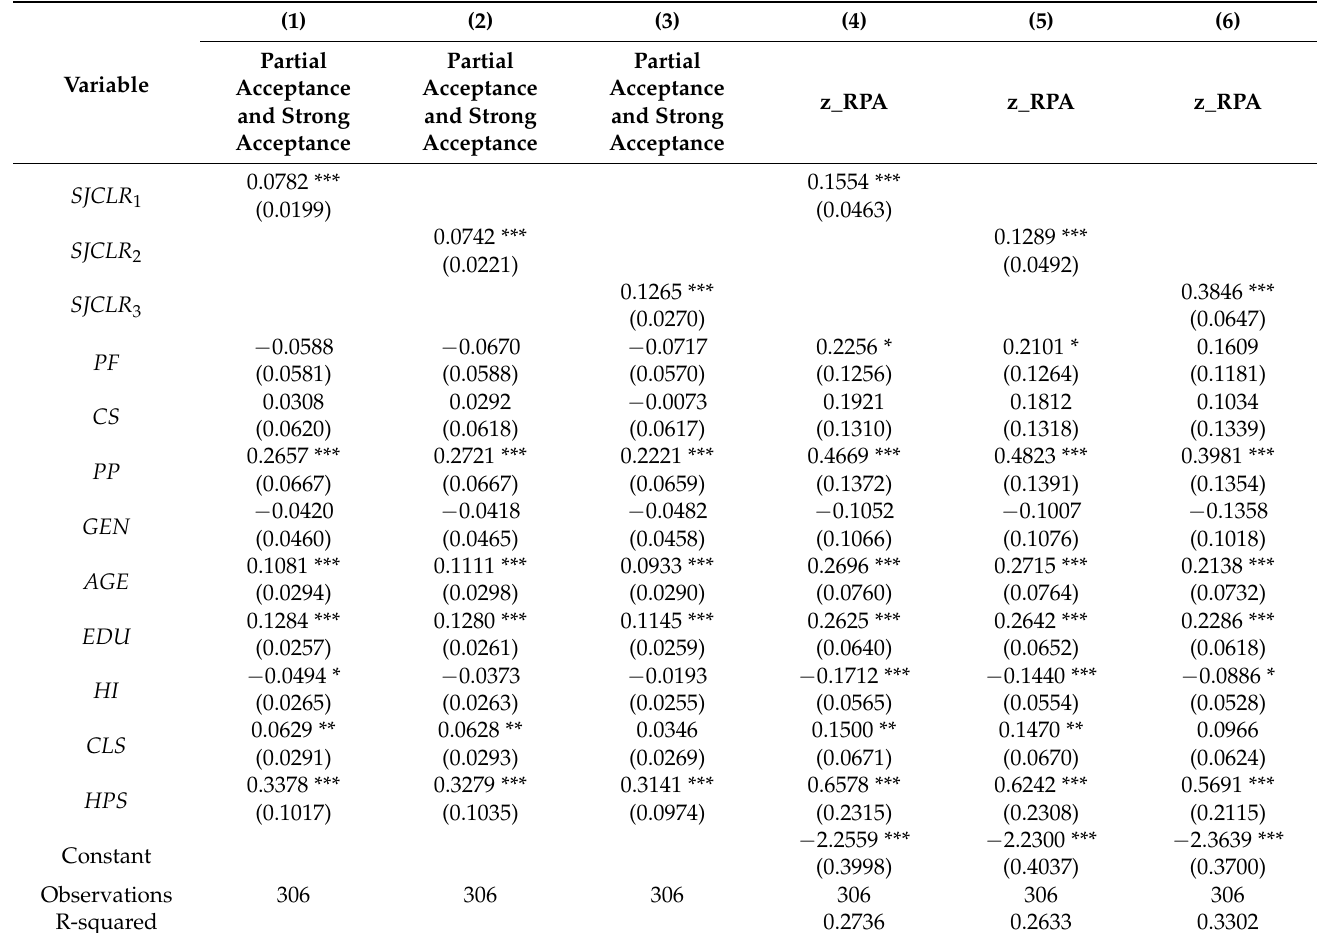
Table 7. Probit model results (marginal effects) and OLS regression